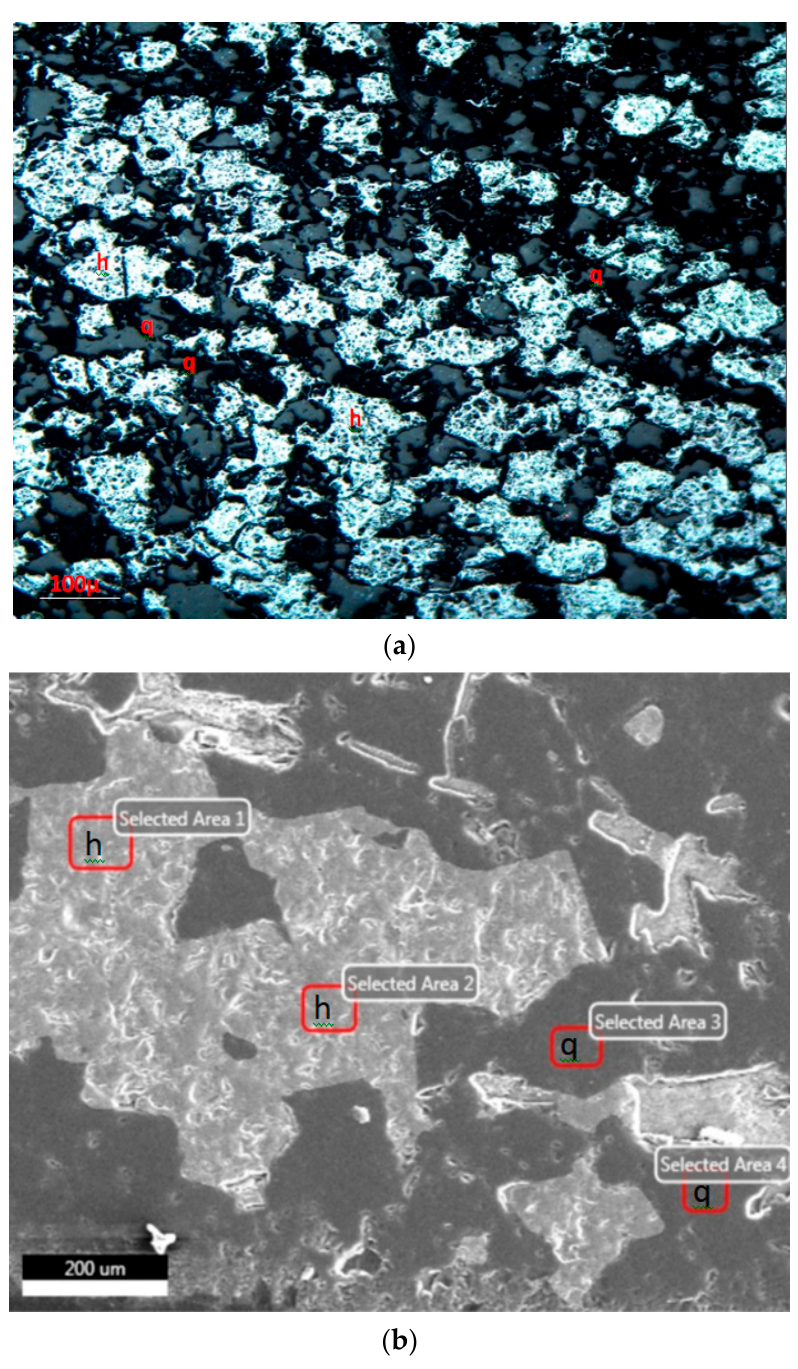
Figure 2. ( a ) Very fine-grained hematite interlocked with very fine-grained quartz grains in BHQ (reflected light × 100) and ( b ) EPMA image analysis, indicating mainly hematite and quartz mostly free from each other at − 0.1 mm. h: hematite; q: quartz